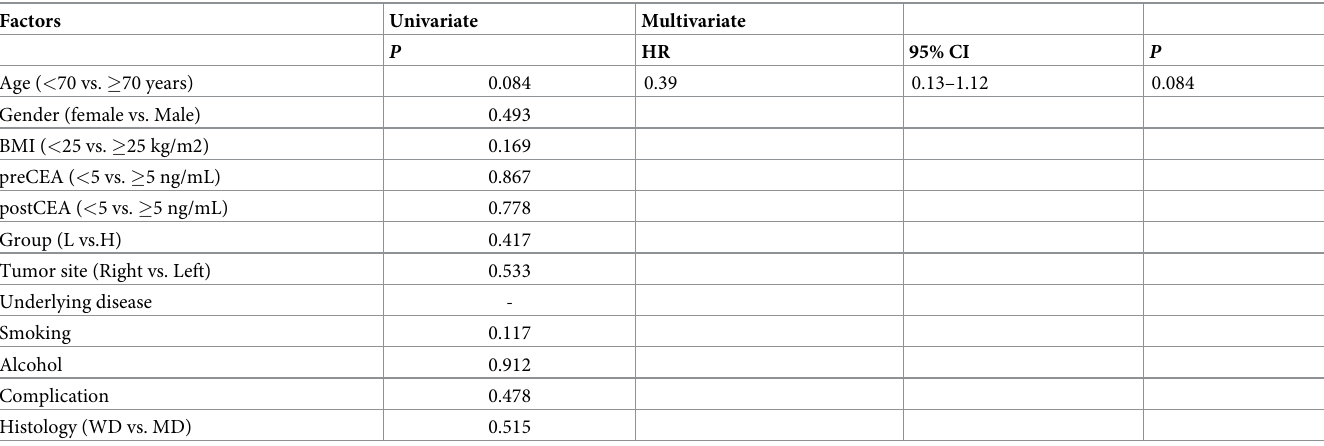
Table 8. Uni- and multivariate analysis of risk factors associated with recurrence using Cox regression model in patients with